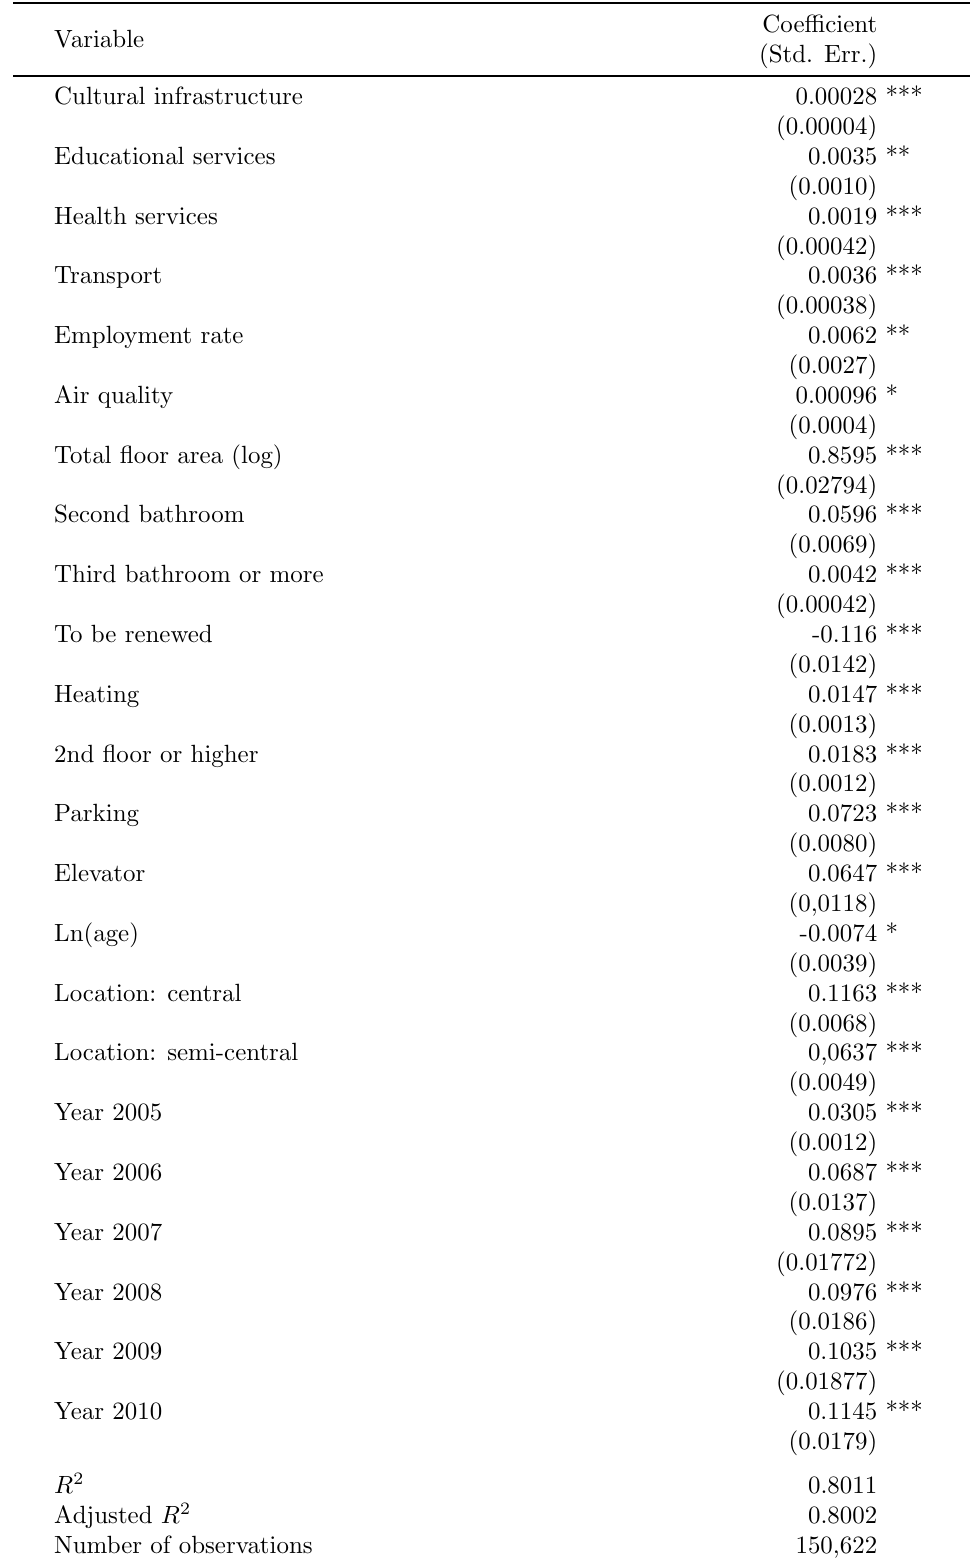
Table A.2: Estimation results for the housing price equation